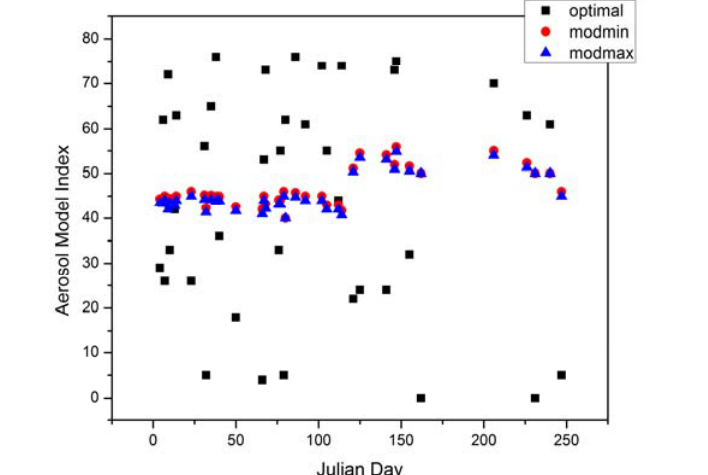
Figure 4. Automatic bounding aerosol model selection (modmin, modmax) vs. optimal aerosol model selection for L (412), chosen from the entire set of 80 aerosol models, n w Martha’s Vineyard,